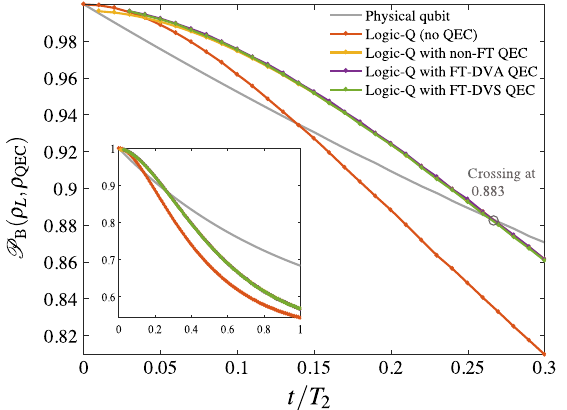
with QEC FIG. 31. Inferior future hardware: Success probability P B QEC according to the shuttling-based, two-species protocol. The error model and scenarios simulated here are the same as in Fig. 30. The operational numbers are scaled to yield a perfor- mance that is 3 times worse than those of the future improved values: Each operation takes 3 times longer, and the gate fidelities are 3 times worse (the environmental dephasing rate remains unchanged). As discussed in the main text, while the performance here is degraded vs the preceding figure, it is nevertheless sufficient to largely demonstrate the goal of beneficial